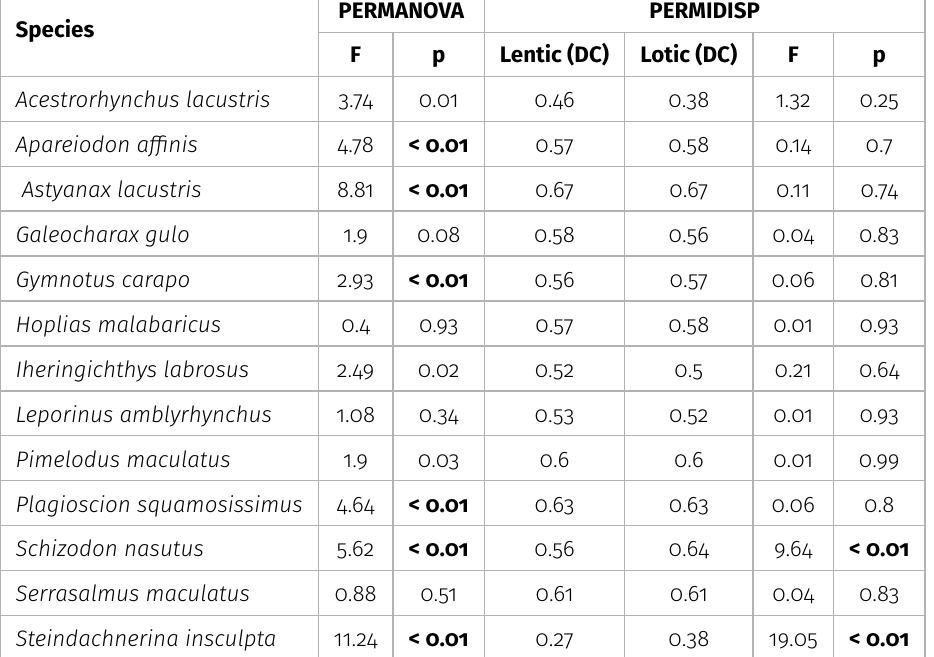
Table III. Results of the permutational multivariate analysis of variance (PERMANOVA) and the permutational analysis of multivariate dispersions (PERMDISP) applied to the diet data of the common species between the stretches (lentic and lotic). DC = Average distance to centroid; significant values are in bold. PERMANOVA PERMIDISP Species F p Lentic (DC) Lotic (DC) F p Acestrorhynchus lacustris 3.74 0.01 0.46 0.38 1.32 0.25 4.78 <